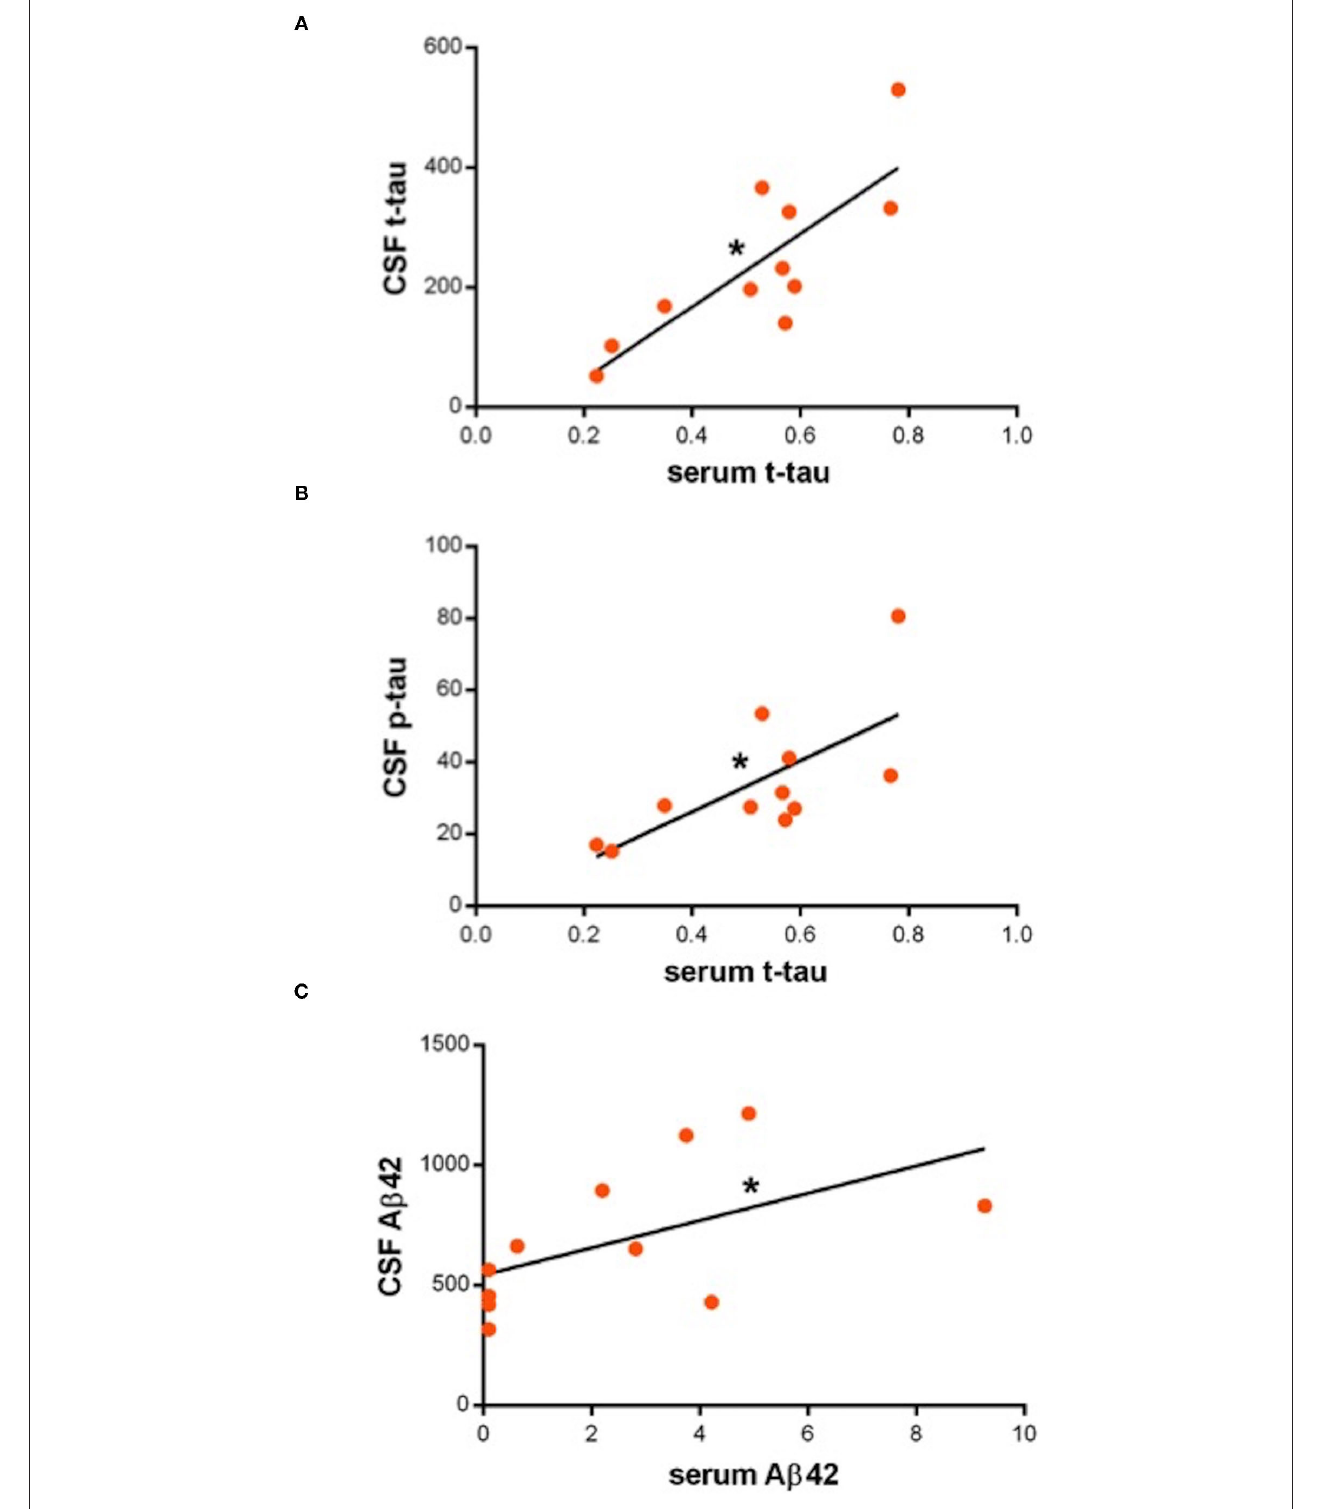
FIGURE 1 | (A–C) Dot-plots showing direct correlations between serum and cerebrospinal fluid (CSF) biomarkers. Asterisks indicate statistical significance. Biomarker concentration is expressed in pg/ml.